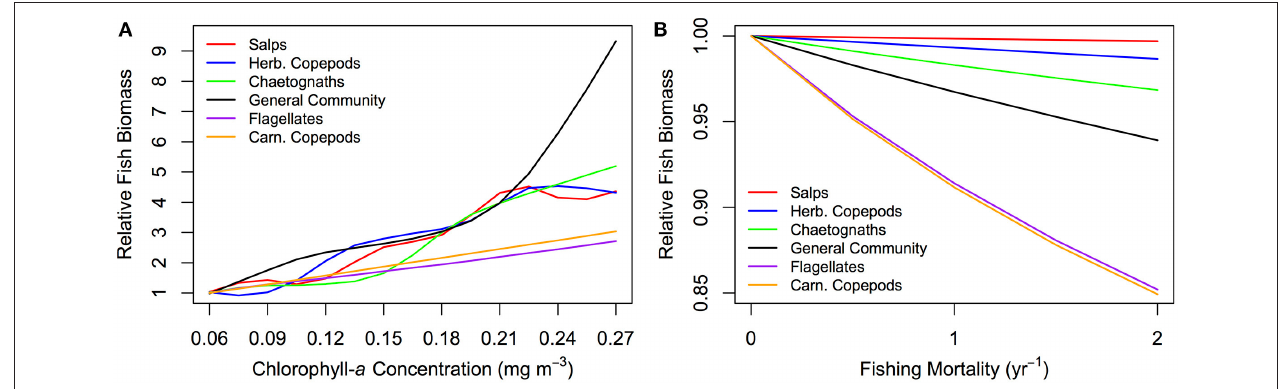
FIGURE 7 | Relative fish biomass against (A) total phytoplankton abundance (chlorophyll- a concentration mg m − 3 ) and (B) fishing mortality (yr − 1 ) for fish communities supported by a zooplankton community with the feeding characteristics of different functional groups. The relative fish biomass is calculated from the total fish biomass divided by the total fish biomass at (A) the lowest phytoplankton abundance (0.06mg m − 3 chlorophyll- a ) and (B) no fishing mortality (0 yr − 1